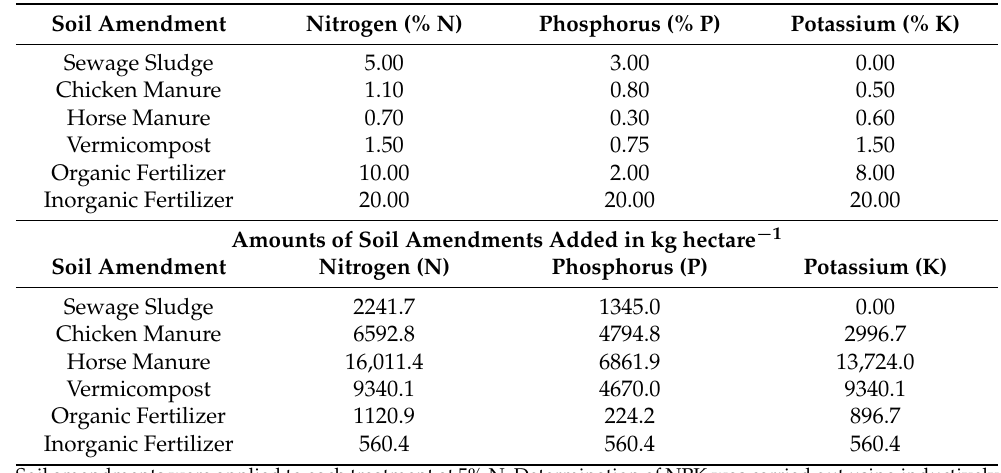
Table 1. Concentrations of NPK in animal manures, organic commercial fertilizer, and inorganic mineral fertilizer used for growing turnip, Brassica rapa (Fayette County, Kentucky, USA).